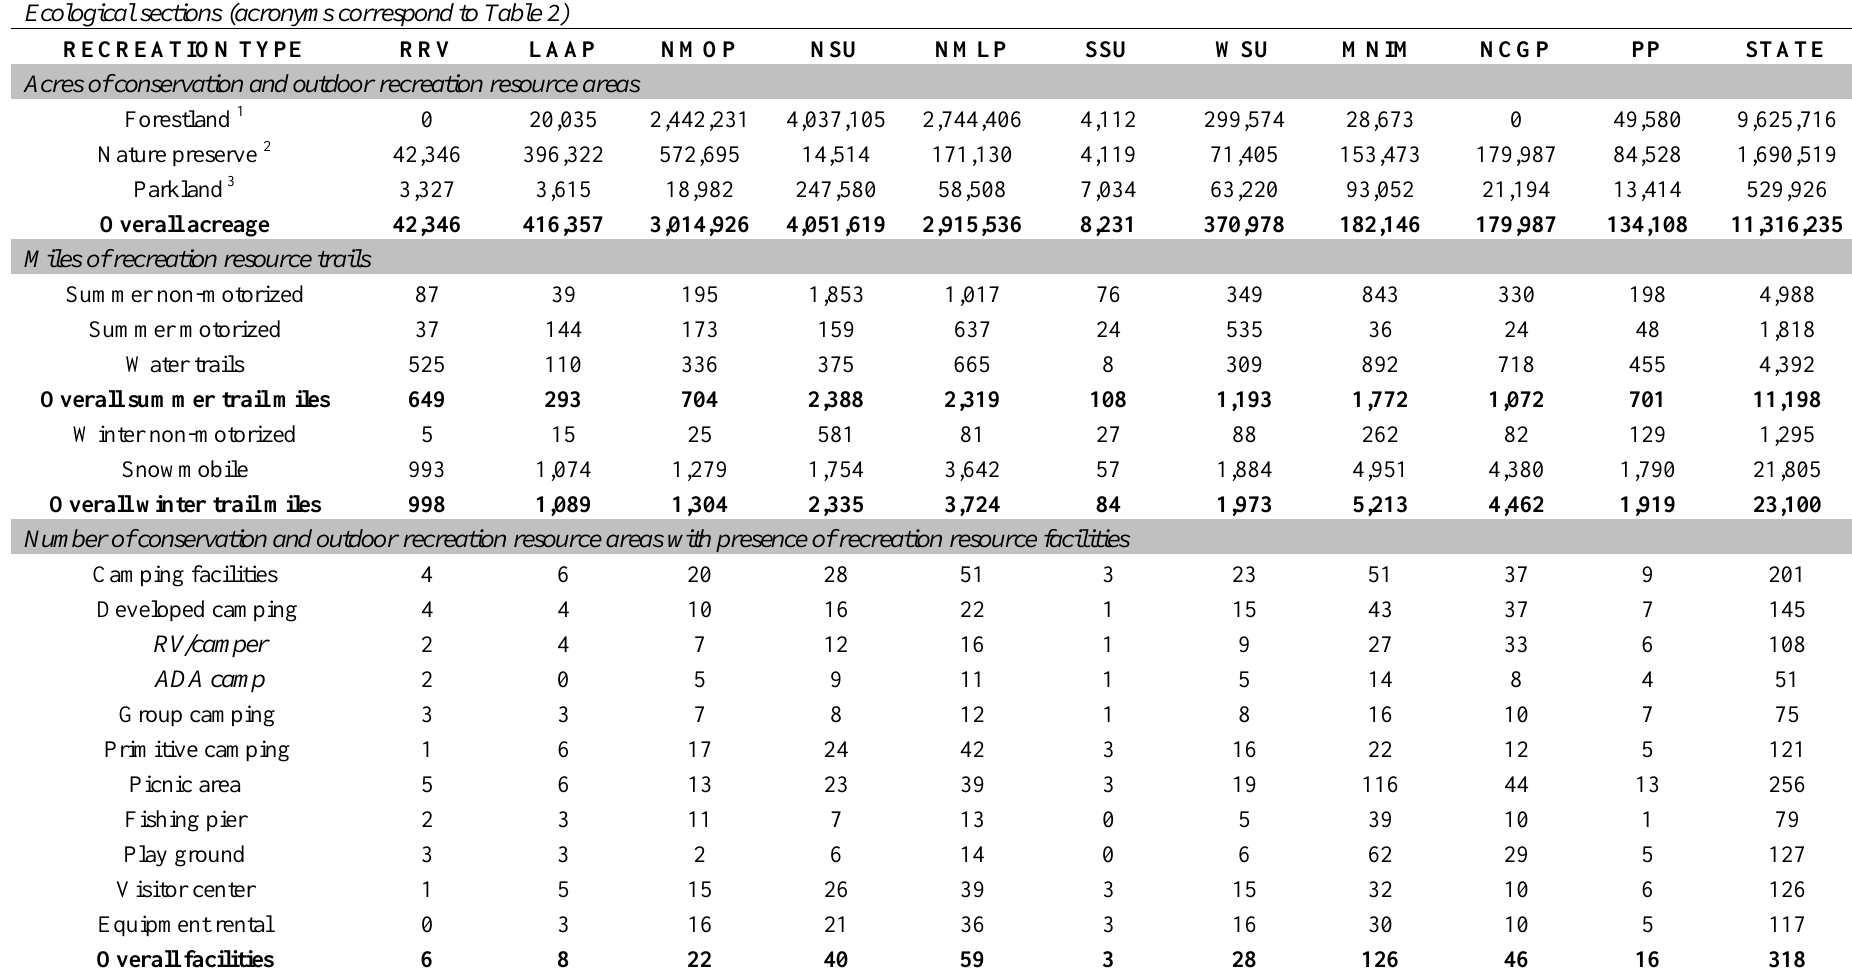
Table 3. Supply of conservation and outdoor recreation resources by ecological